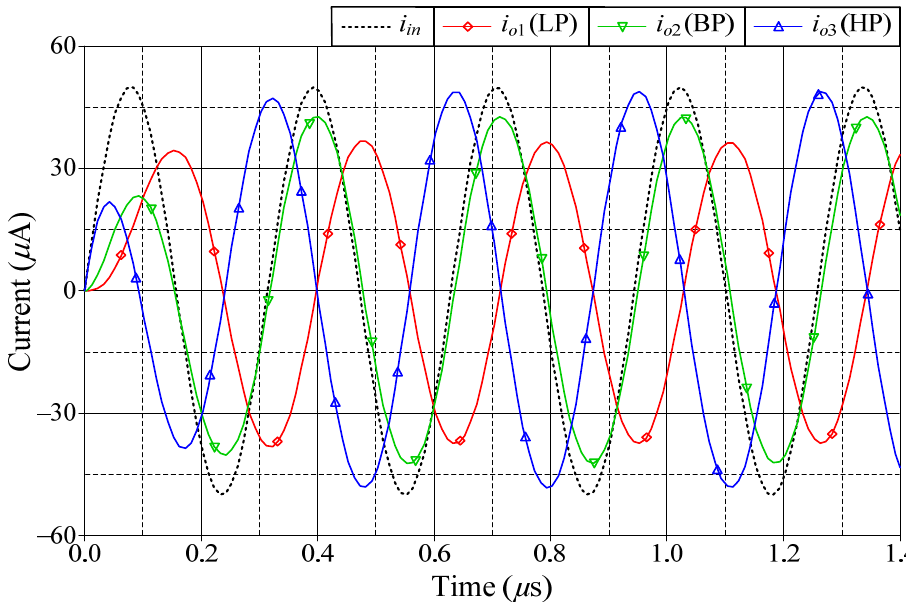
Figure 11. Time-domain responses of the LP, BP, and HP filters in CM.